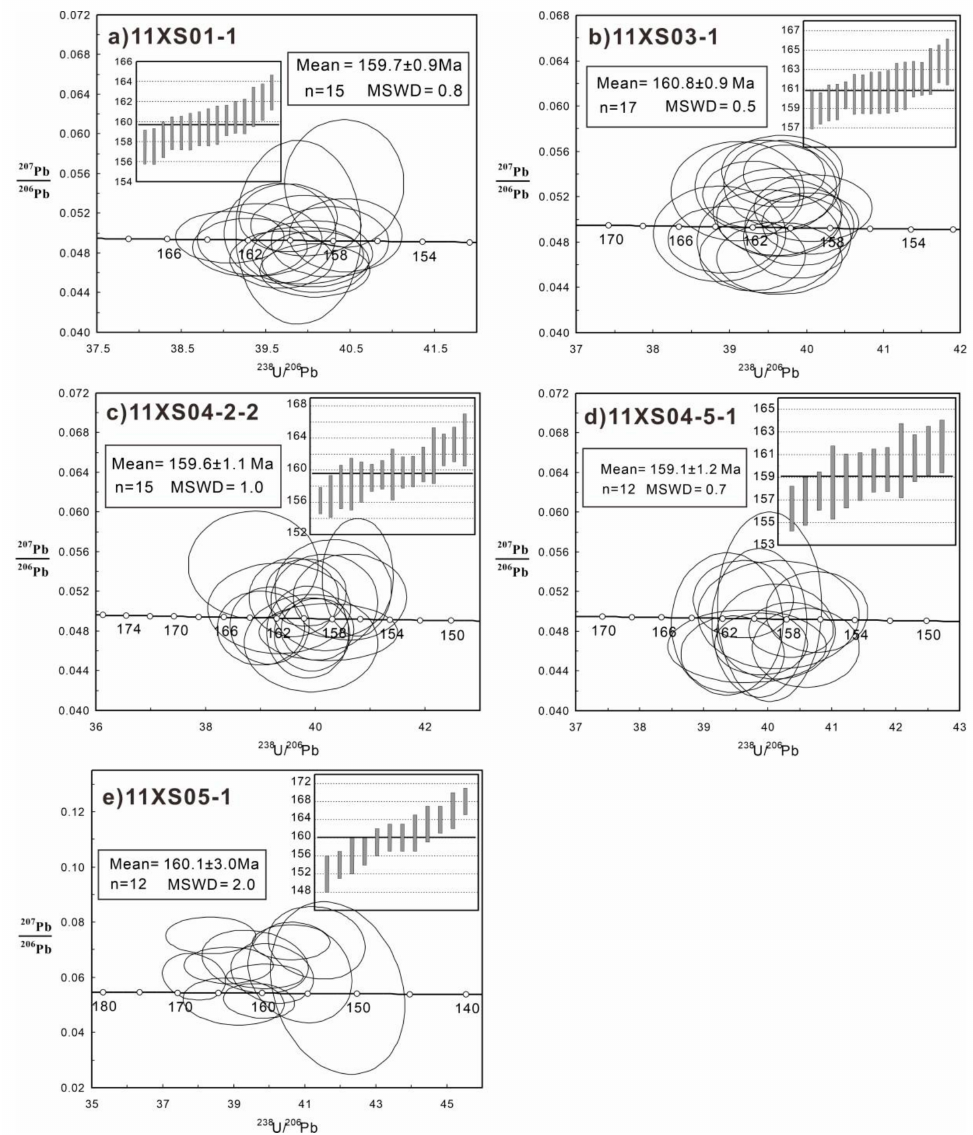
Figure 4. U-Pb concordia diagram of zircon in the Guiping complex: ( a ) sample 11XS01-1, ( b ) sample 11XS03-1, ( c ) sample 11XS04-2-2, ( d ) sample 11XS04-5-1, and ( e ) sample